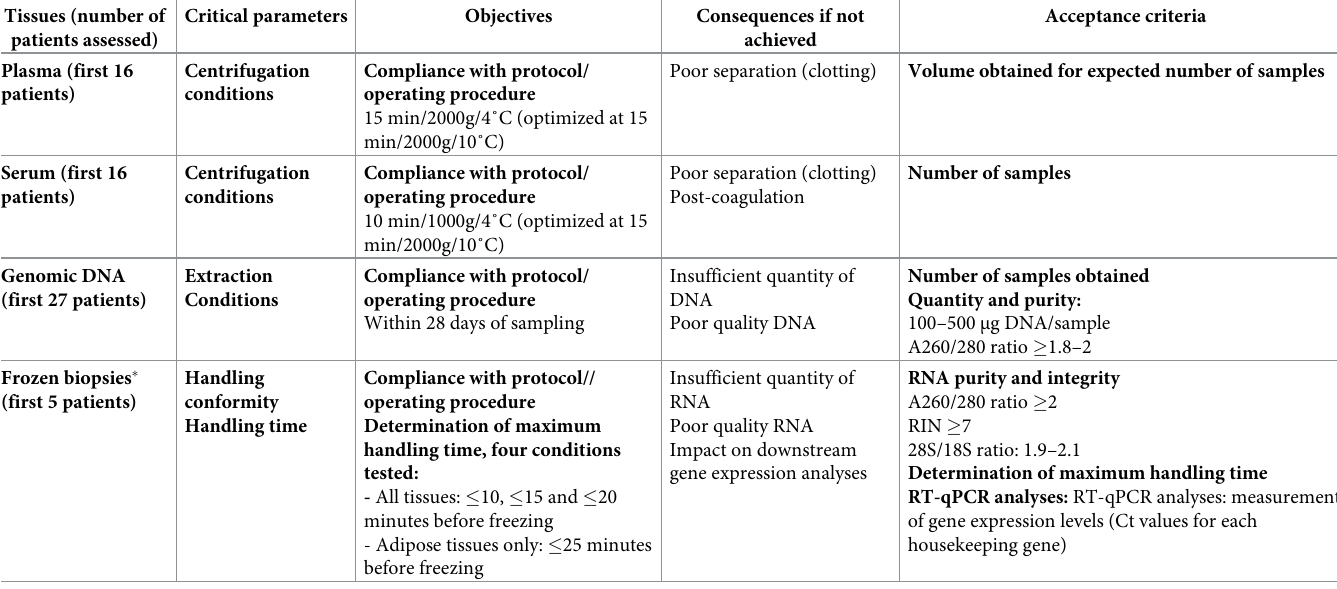
� Biopsies: subcutaneous adipose tissue (umbilical region), visceral adipose tissue (greater omentum, gastrosplenic region), liver (segment II or III, left lobe), abdominal skeletal muscle (rectus